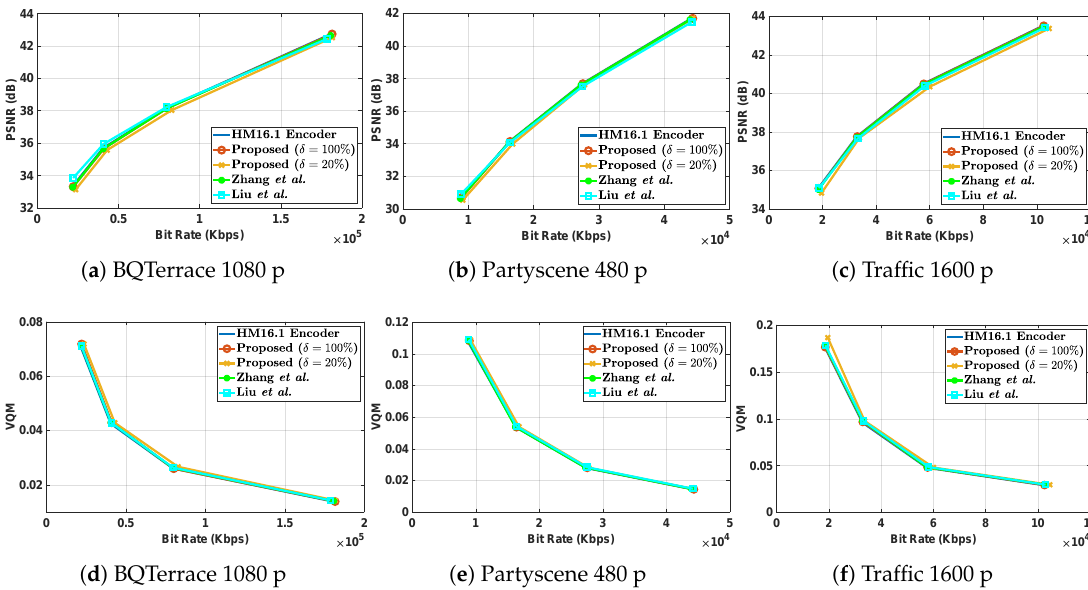
Figure 6. RD performance of three sample video sequences. Top row corresponds to RD graphs drawn with PSNR as the quality metric. Bottom row corresponds to the VQM as the quality metric. RD: